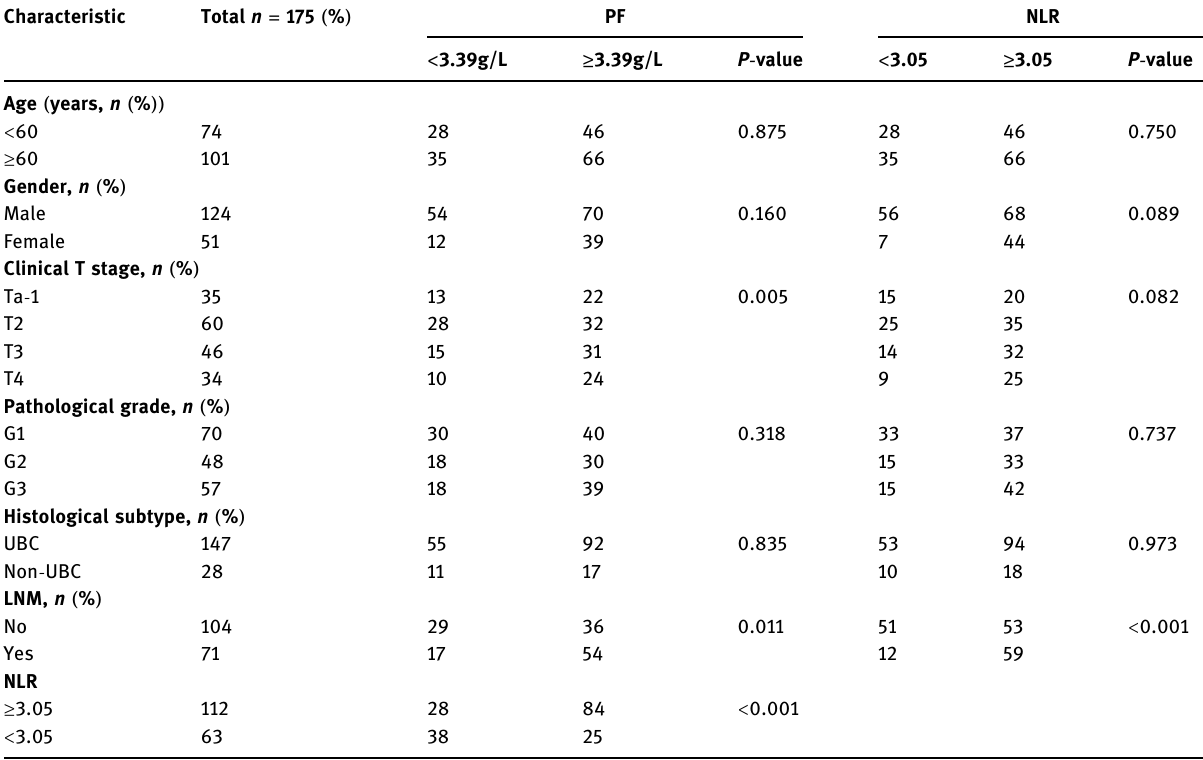
Table S1: Clinicopathological features of 175 BC patients strati fi ed by PF and NLR